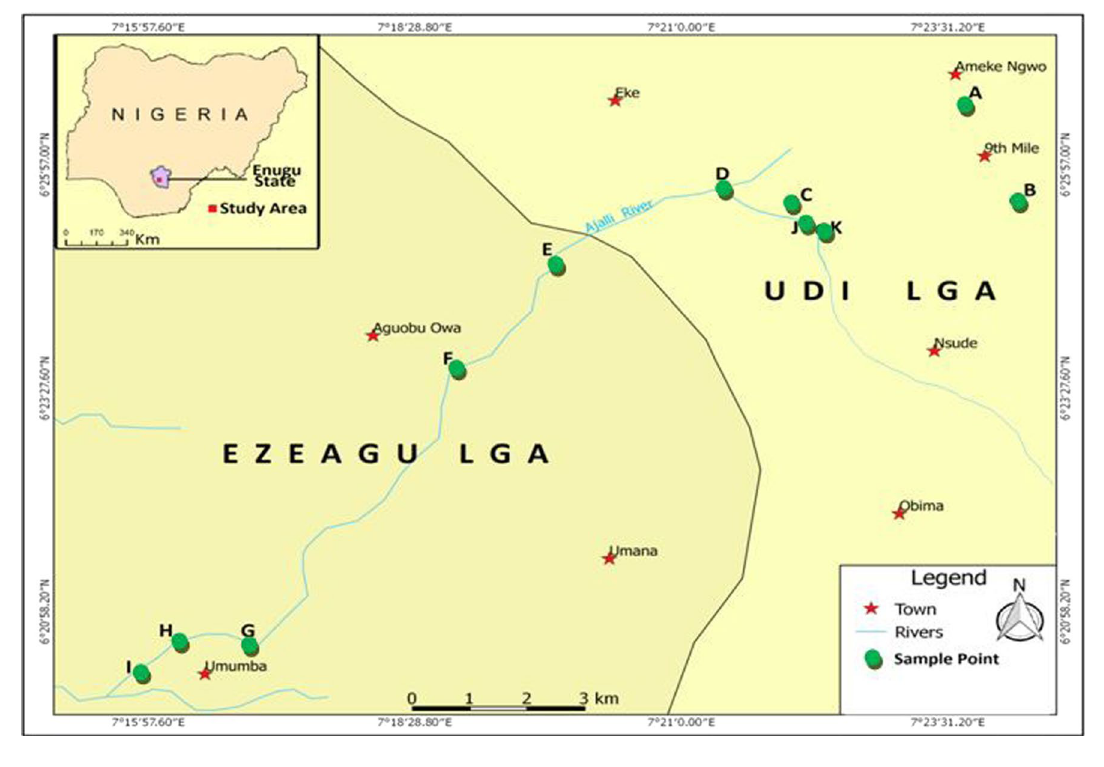
Fig. 1 Map of the study area